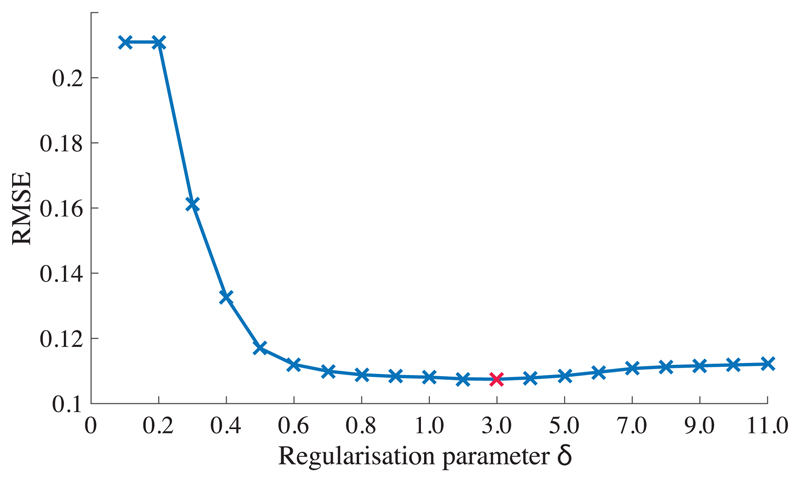
A presentative sample [the tumor specimen shown in the later figure Fig. 6(a)] demonstrating how the regularization parameter δ is selected. RMSEs between CTV and Cgt of different regularization parameter δ values. The red cross marker indicates that the minimum RMSE locates at δ = 3.0.